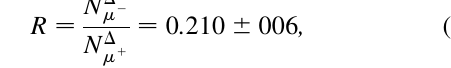
25 GeV muon beam